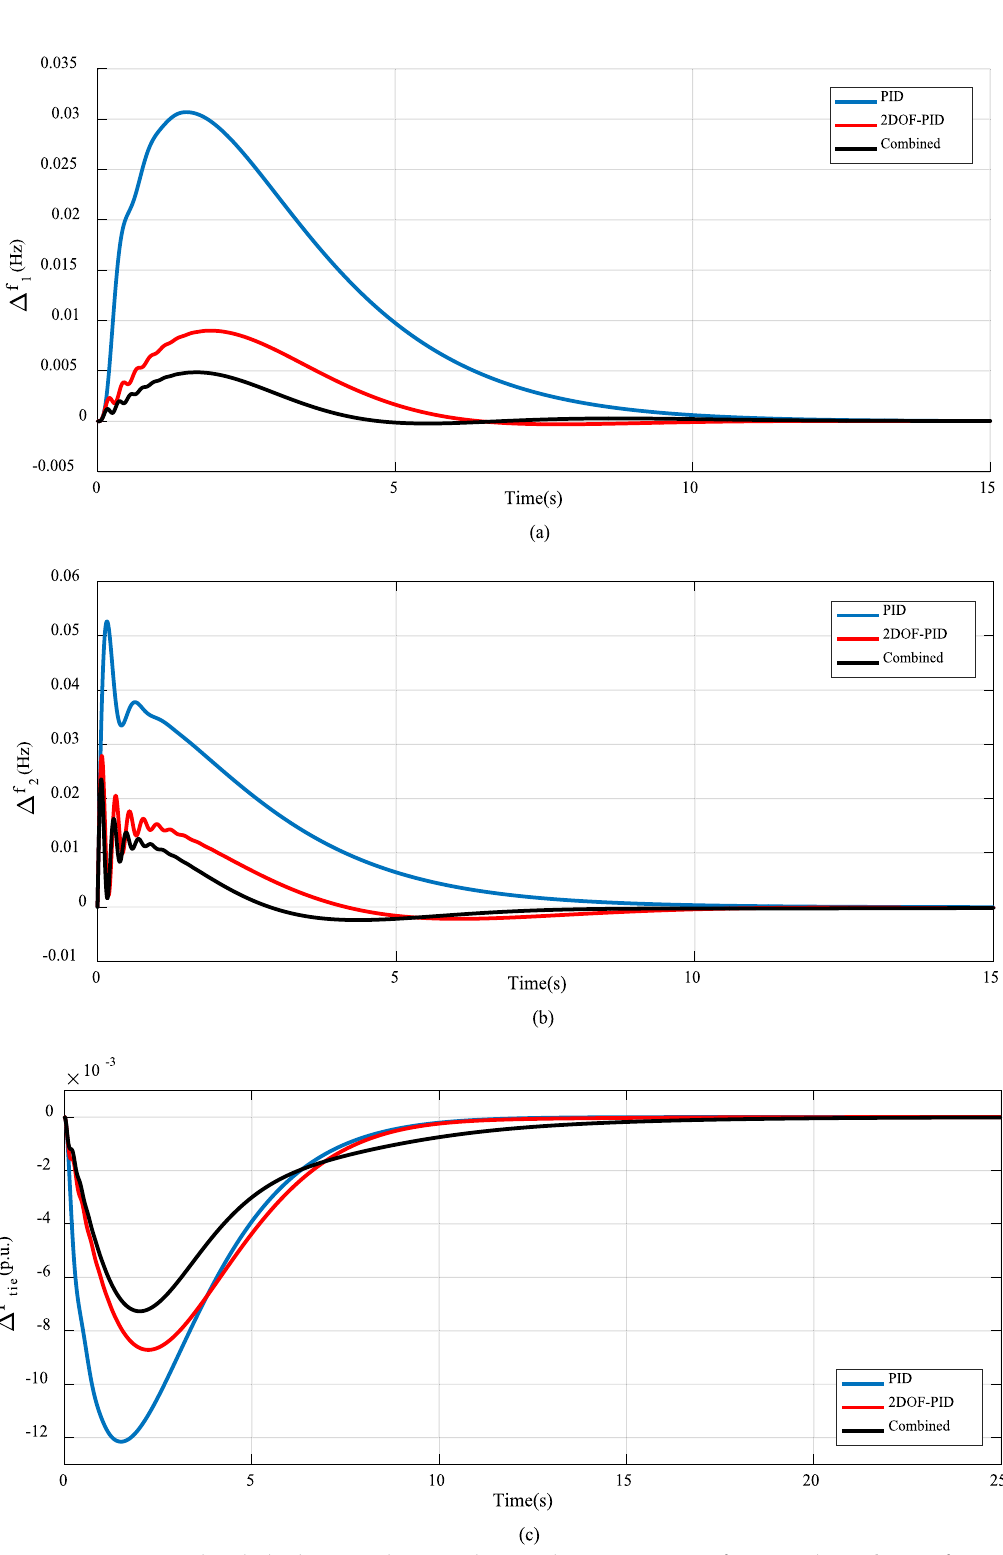
Fig. 6 Improvement in responses when the load in area 2 changes without wind integration. a Area I frequency change; b Area II frequency change; c Tie line power